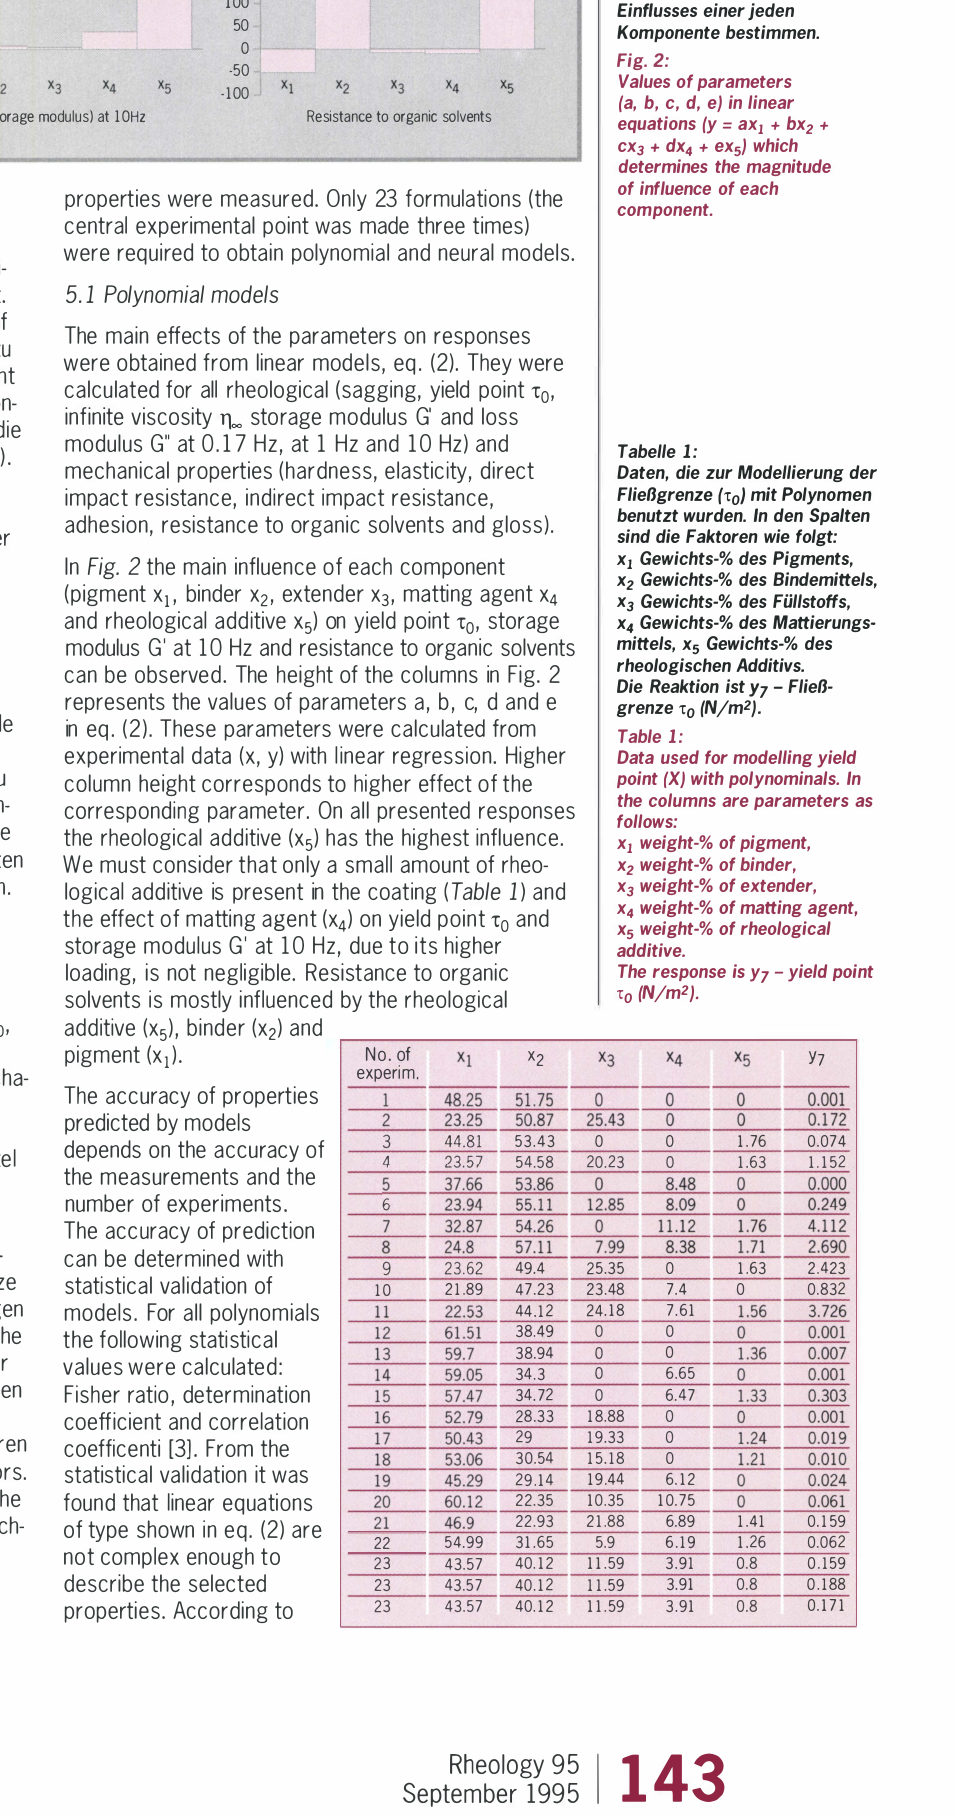
Fig. 2: Values of parameters